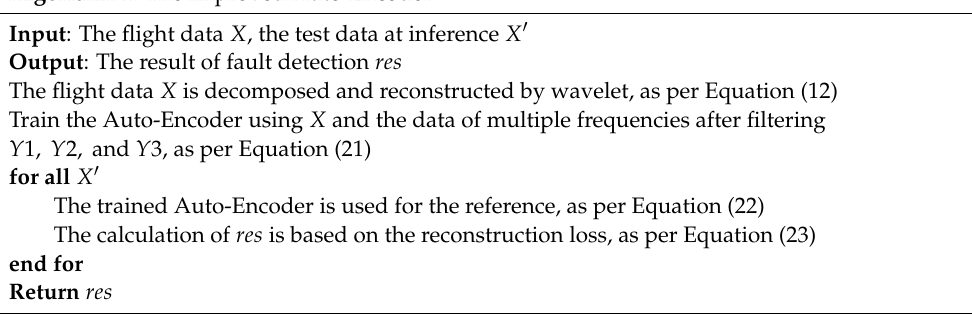
Algorithm 1 : The improved